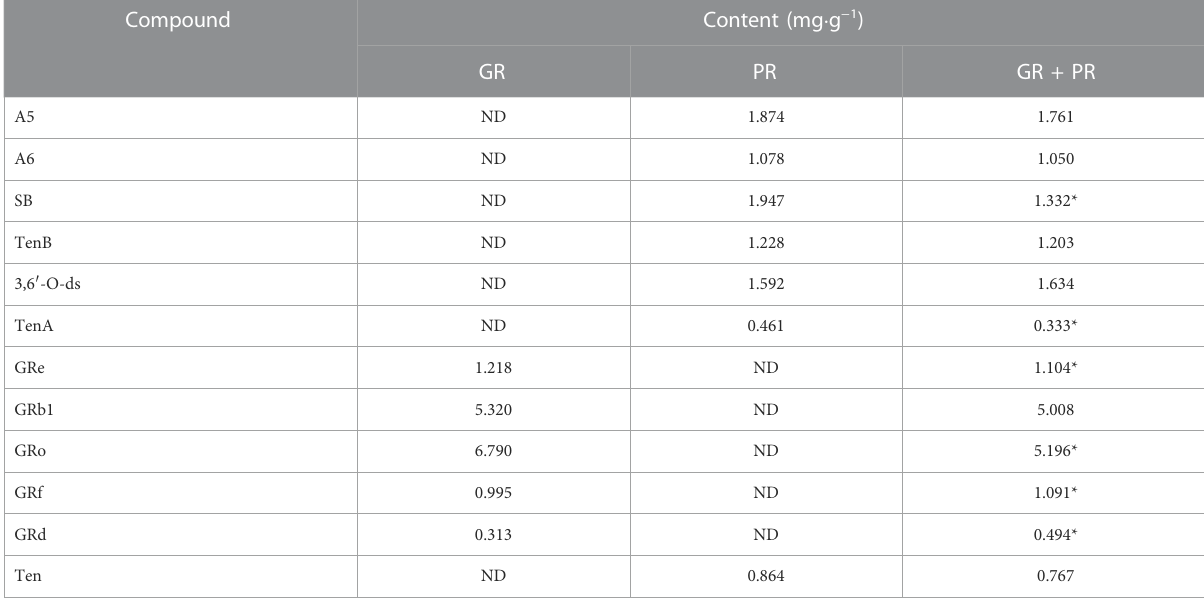
TABLE 3 The contents of 12 components in the test solution (n = 3).